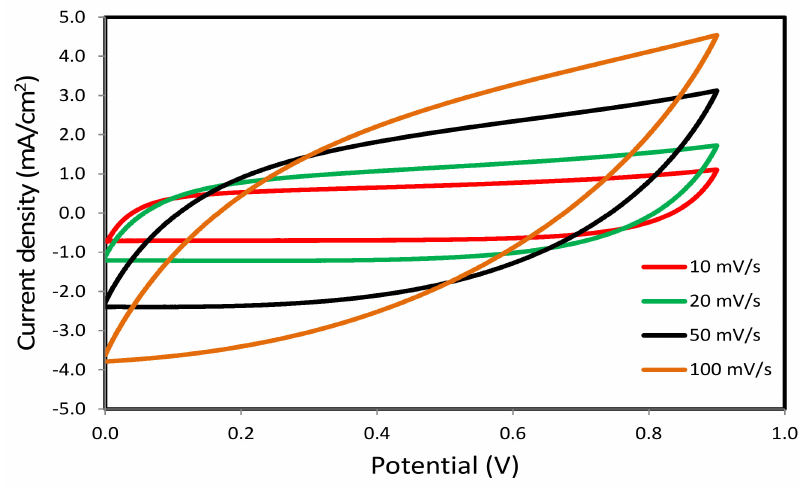
Figure 8. Cyclic voltammetry (CV) curves of the fabricated electrochemical double-layer capacitor (EDLC) at di ff erent scan rates. Table 2. Specific capacitance ( C s ) of the electrochemical double-layer capacitor (EDLC) at di ff erent scan